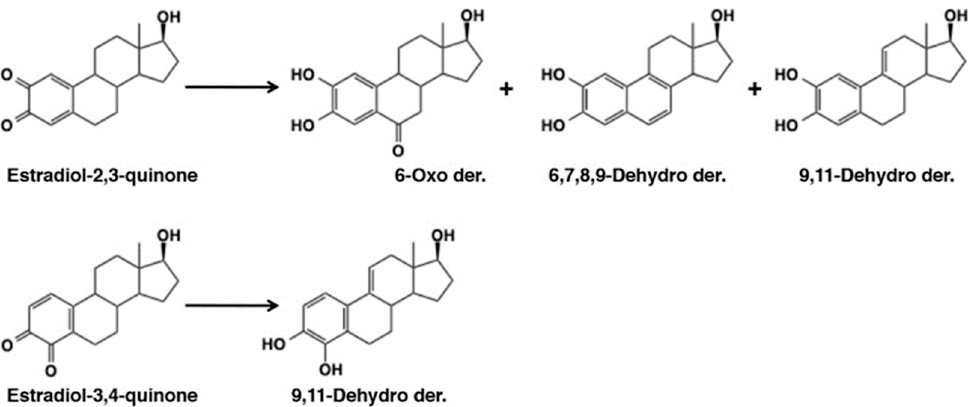
Figure 23. Reaction of β -estradiol quinones [118]. Note that those quinones undergo tautomerization to quinone methides which give rise to the secondary products.